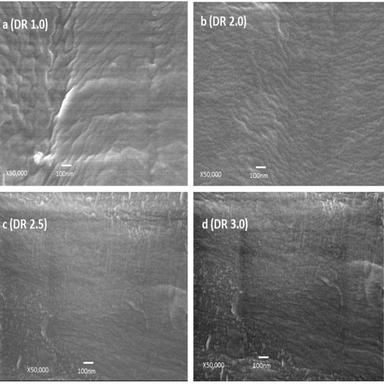
SEM images of biaxially stretched (DR 1.0 to DR 3.0) PCTN film samples.